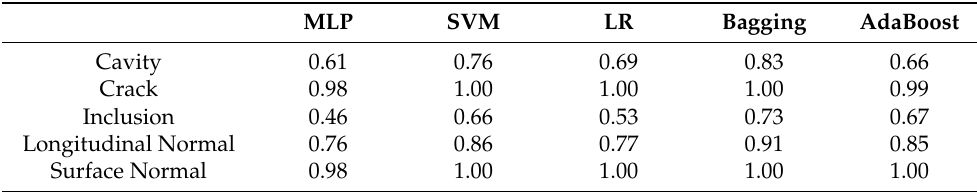
Table 3. The F1 score of different algorithms on the identification of different defect types of an aero-engine blade. MLP SVM LR Bagging AdaBoost Cavity 0.61 0.76 0.69 0.83 0.66 Crack 0.98 1.00 1.00 1.00 0.99 Inclusion 0.46 0.66 0.53 Longitudinal